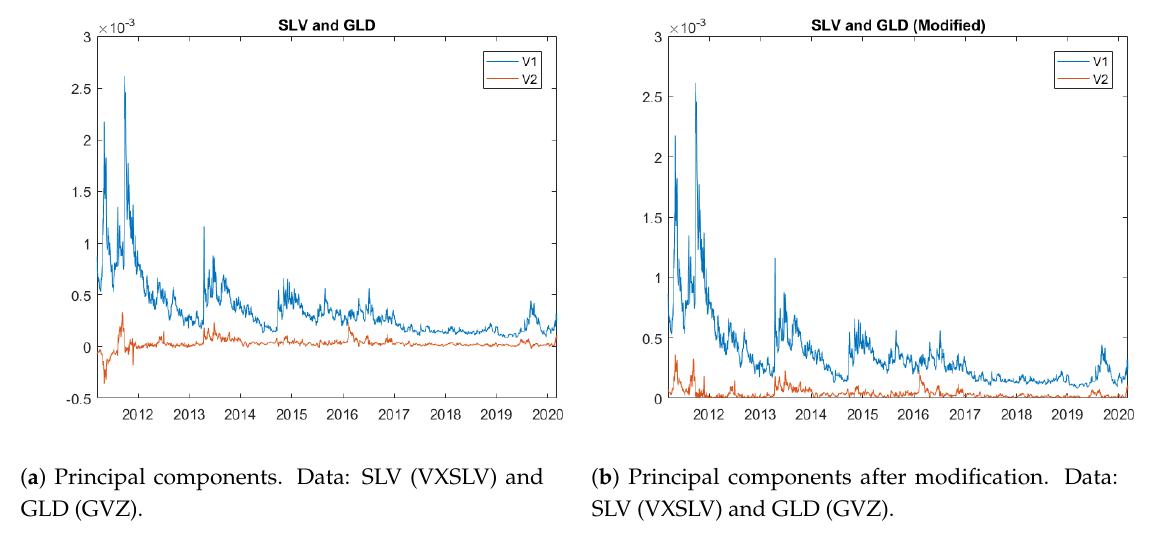
Figure 6. Principal components with volatility indexes’ data. Table 2. Estimated volatility group parameters with empirical data (VIX and